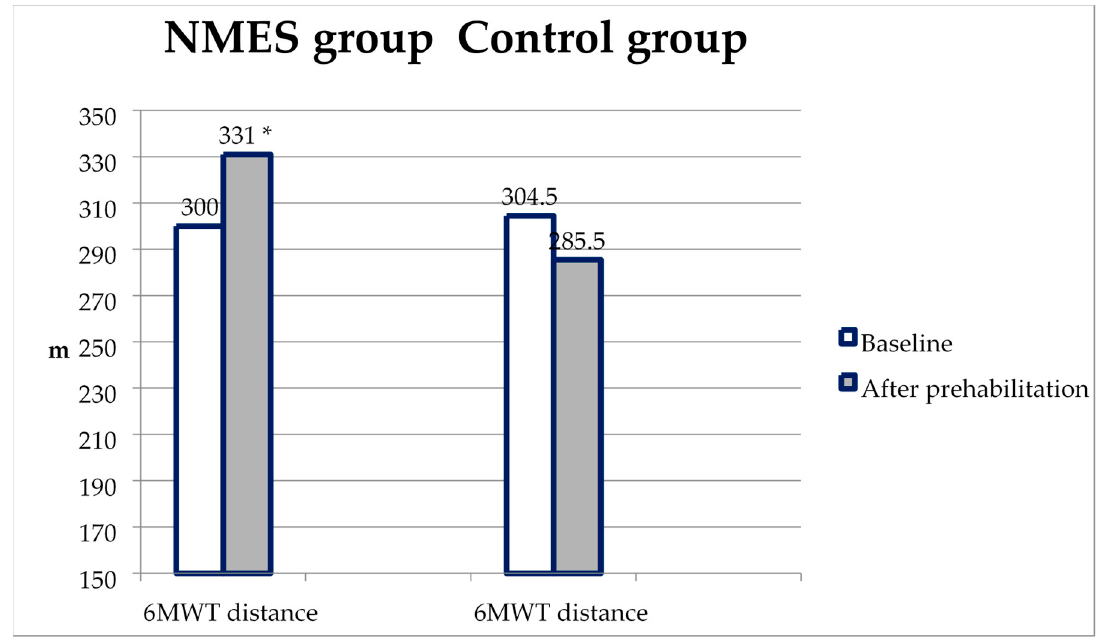
Figure 5. 6 MWT distance changes from baseline to the second test in the NMES group and control. *— p < 0.05 compared with the control.